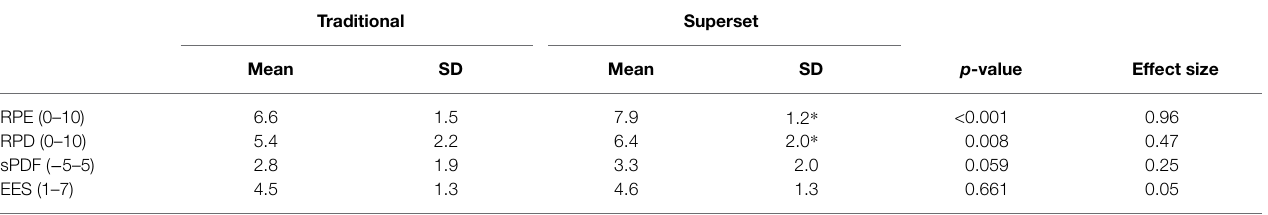
TABLE 3 | Perceptive measures for the traditional and superset session. Traditional